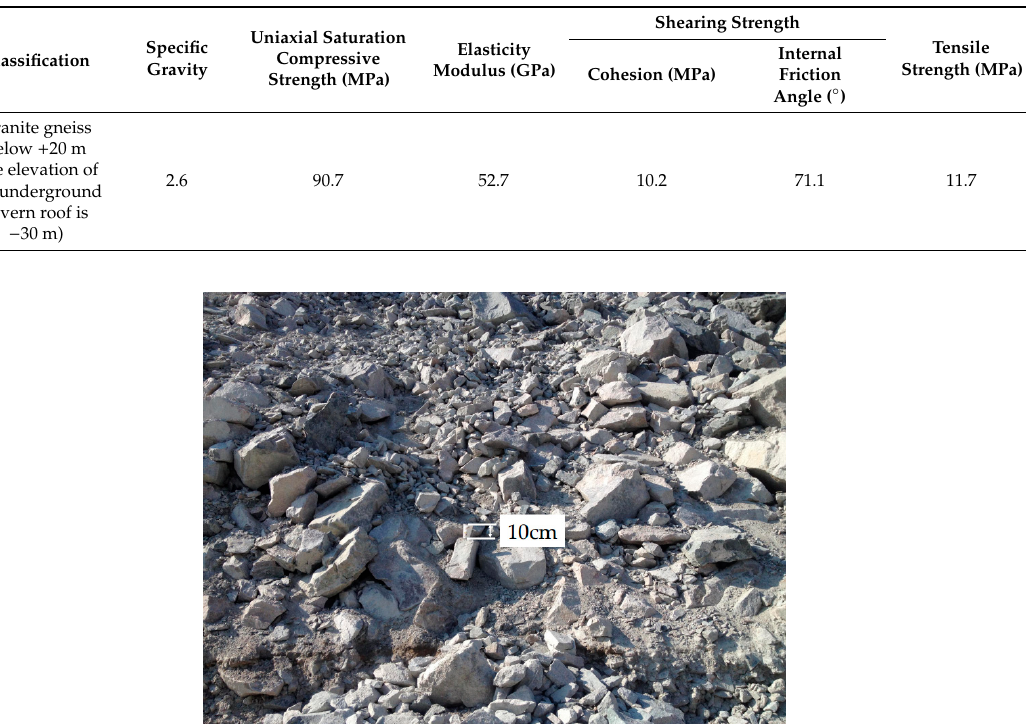
Figure 2. Rock fragments left on the slope after the previous landslide. Table 1. Physical and mechanical properties of intact rocks (from geological survey report). Classification